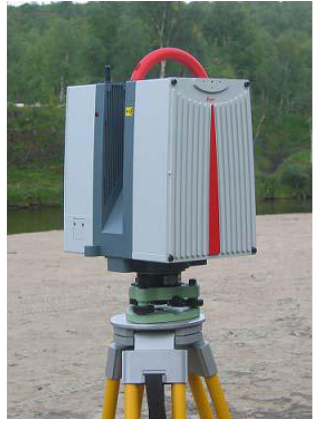
Figure 2: The Leica HDS6000 TLS